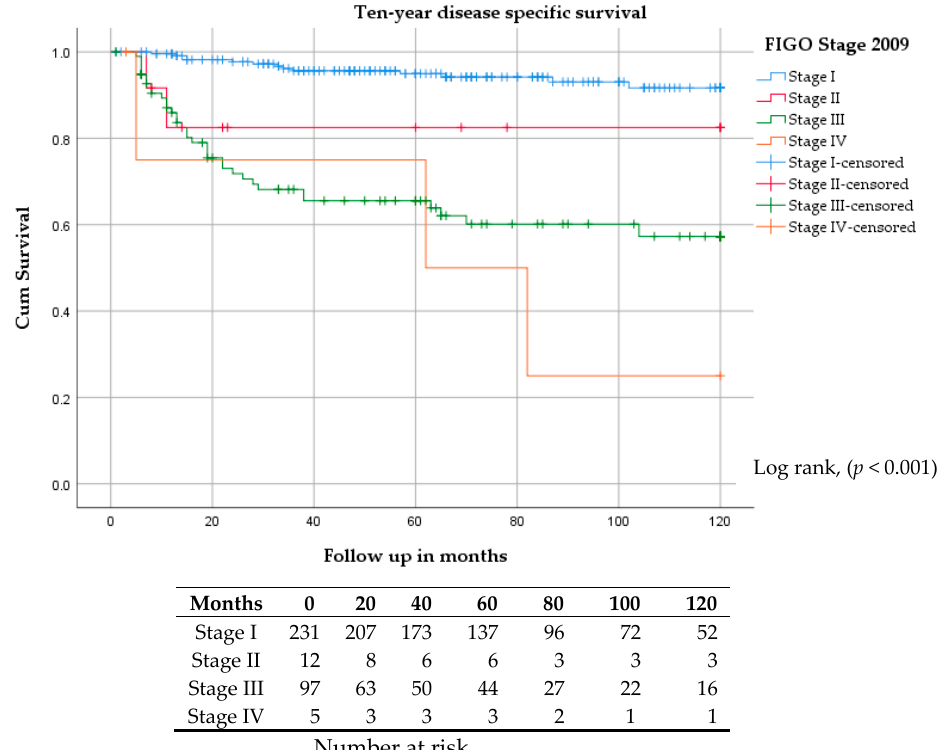
Figure 2. Kaplan–Meier curve for ten-year disease-specific survival stratified by FIGO